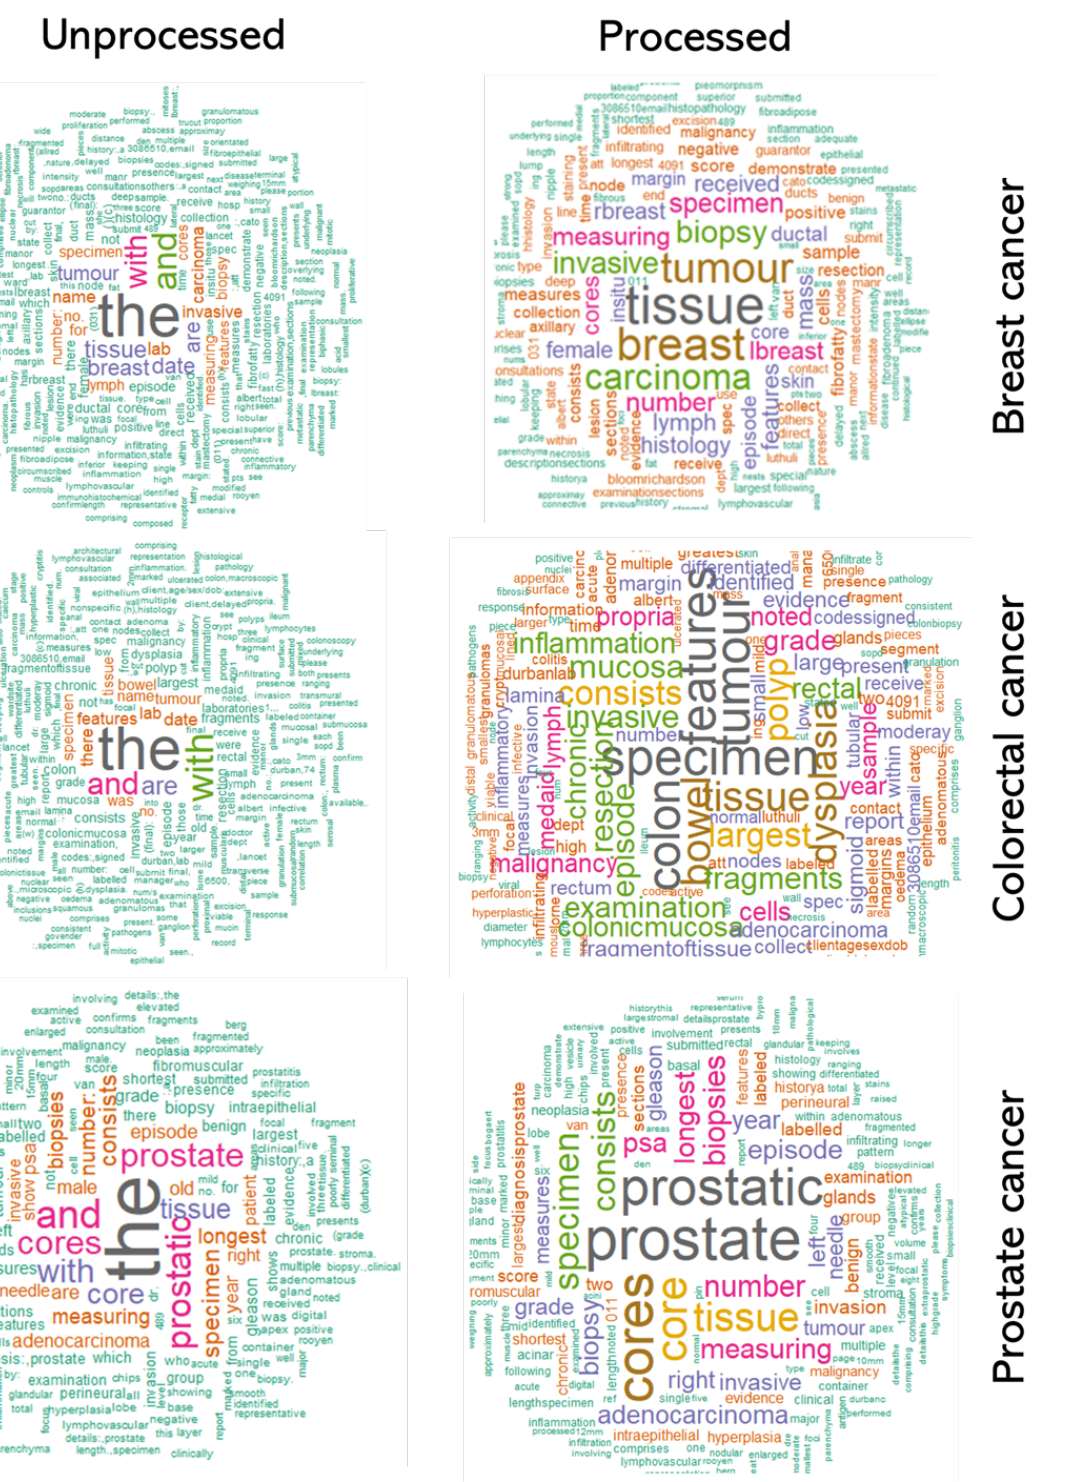
Figure 6. Word cloud of each cancer type for unprocessed and processed pathology reports summarising the most frequently used terms or features in the pathology report. The figures present an overall theme in each cancer type, which is more pronounced in the processed